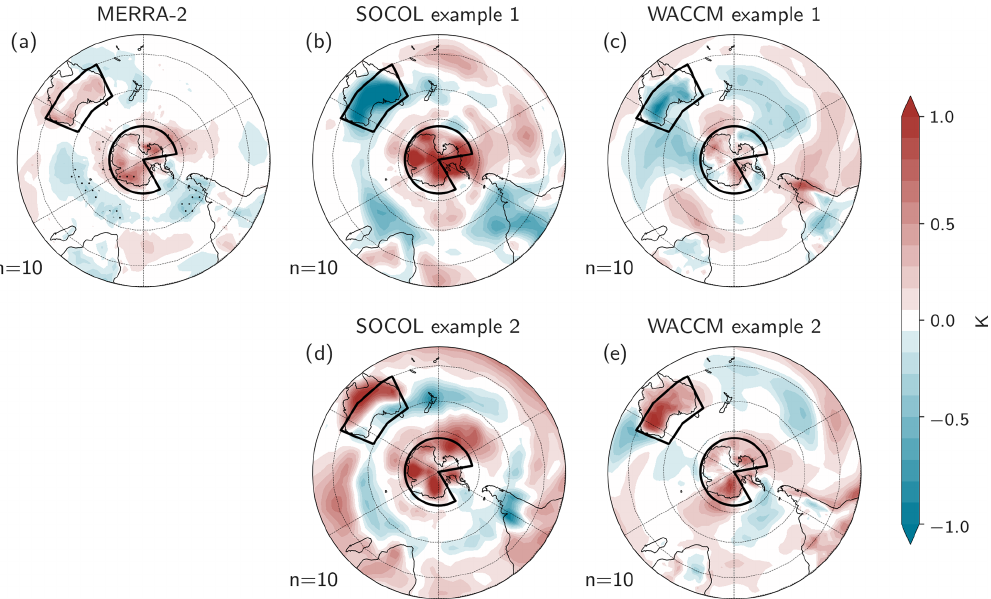
Figure 5. Examples of subsampled ( n = 10) temperature anomaly composites of weak polar vortex regimes for October to January for SOCOL (b, d) and WACCM (c, e) , with the MERRA-2 ( n = 10) composite (a) shown for comparison.